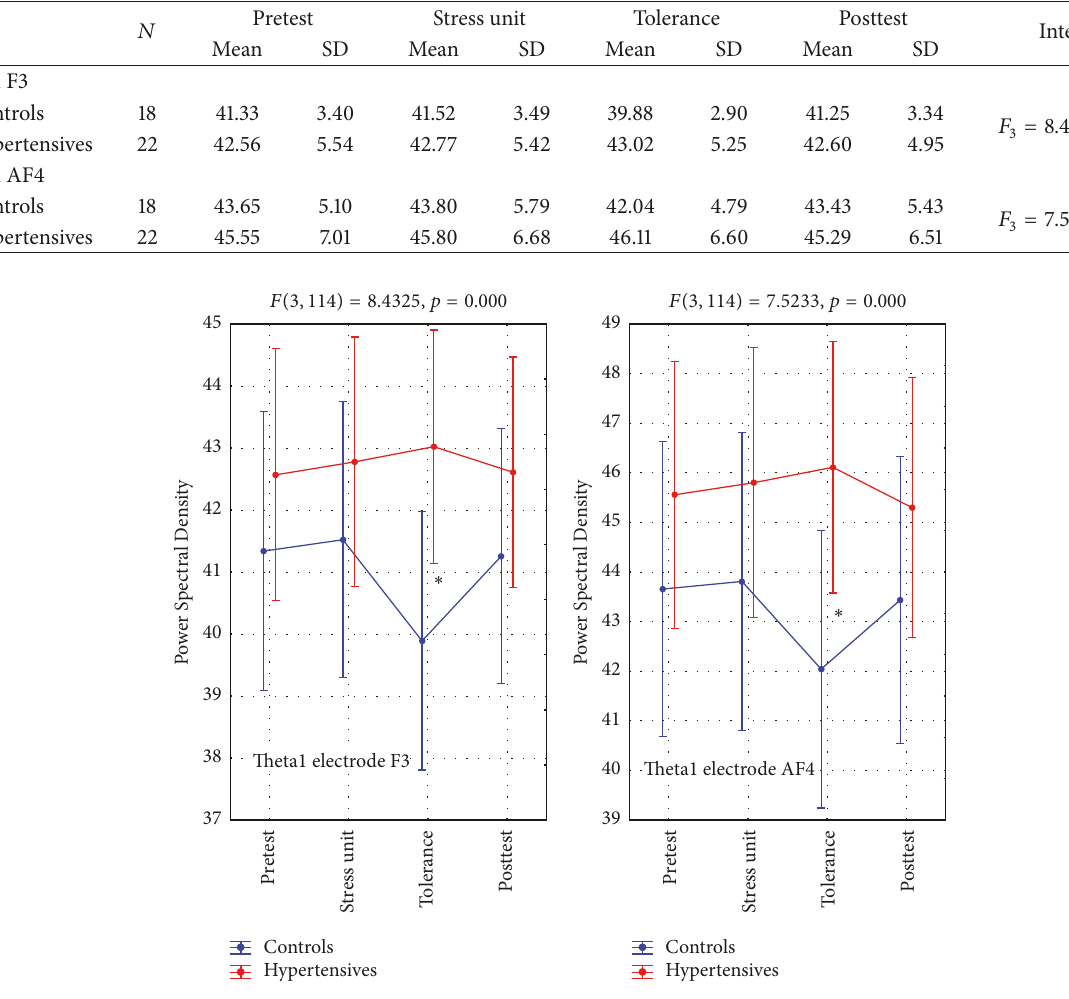
Figure 2: Theta1 brain activity (T1BA). ∗ refers to statistically significant